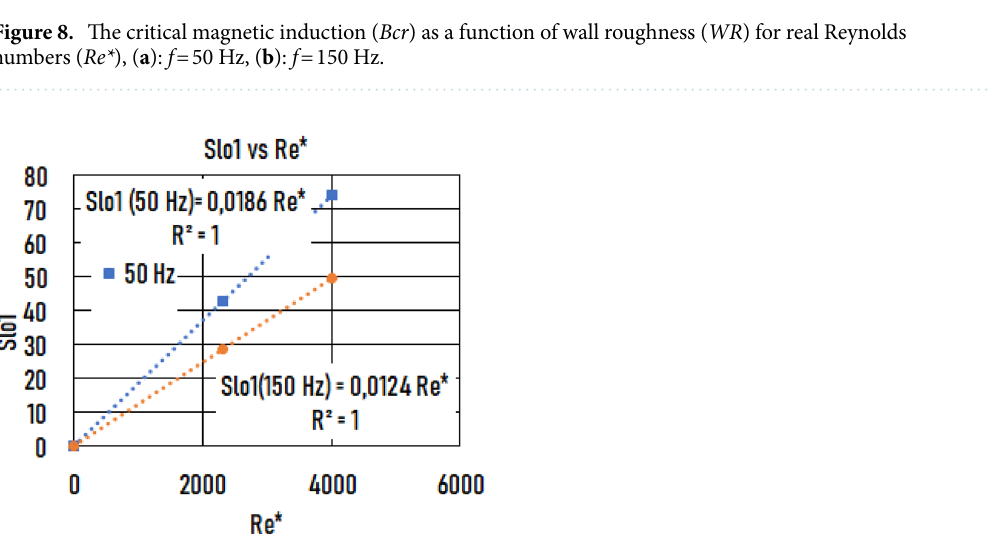
Figure 9. The slope ( Slo1 ) of the critical magnetic induction ( Bcr (wall roughness ( WR ))) function vs. Reynolds number ( Re *